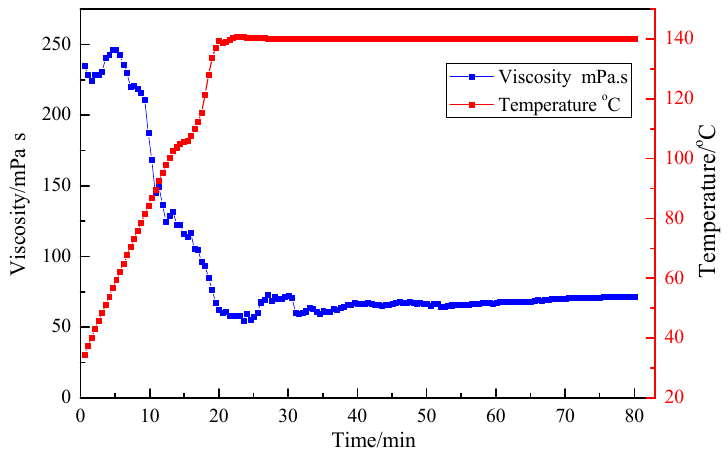
Figure 8. Shear resistance of 3 wt % VES-T with 1 wt % NaSal fracturing fluid at 140 °C, 170 s − 1 .